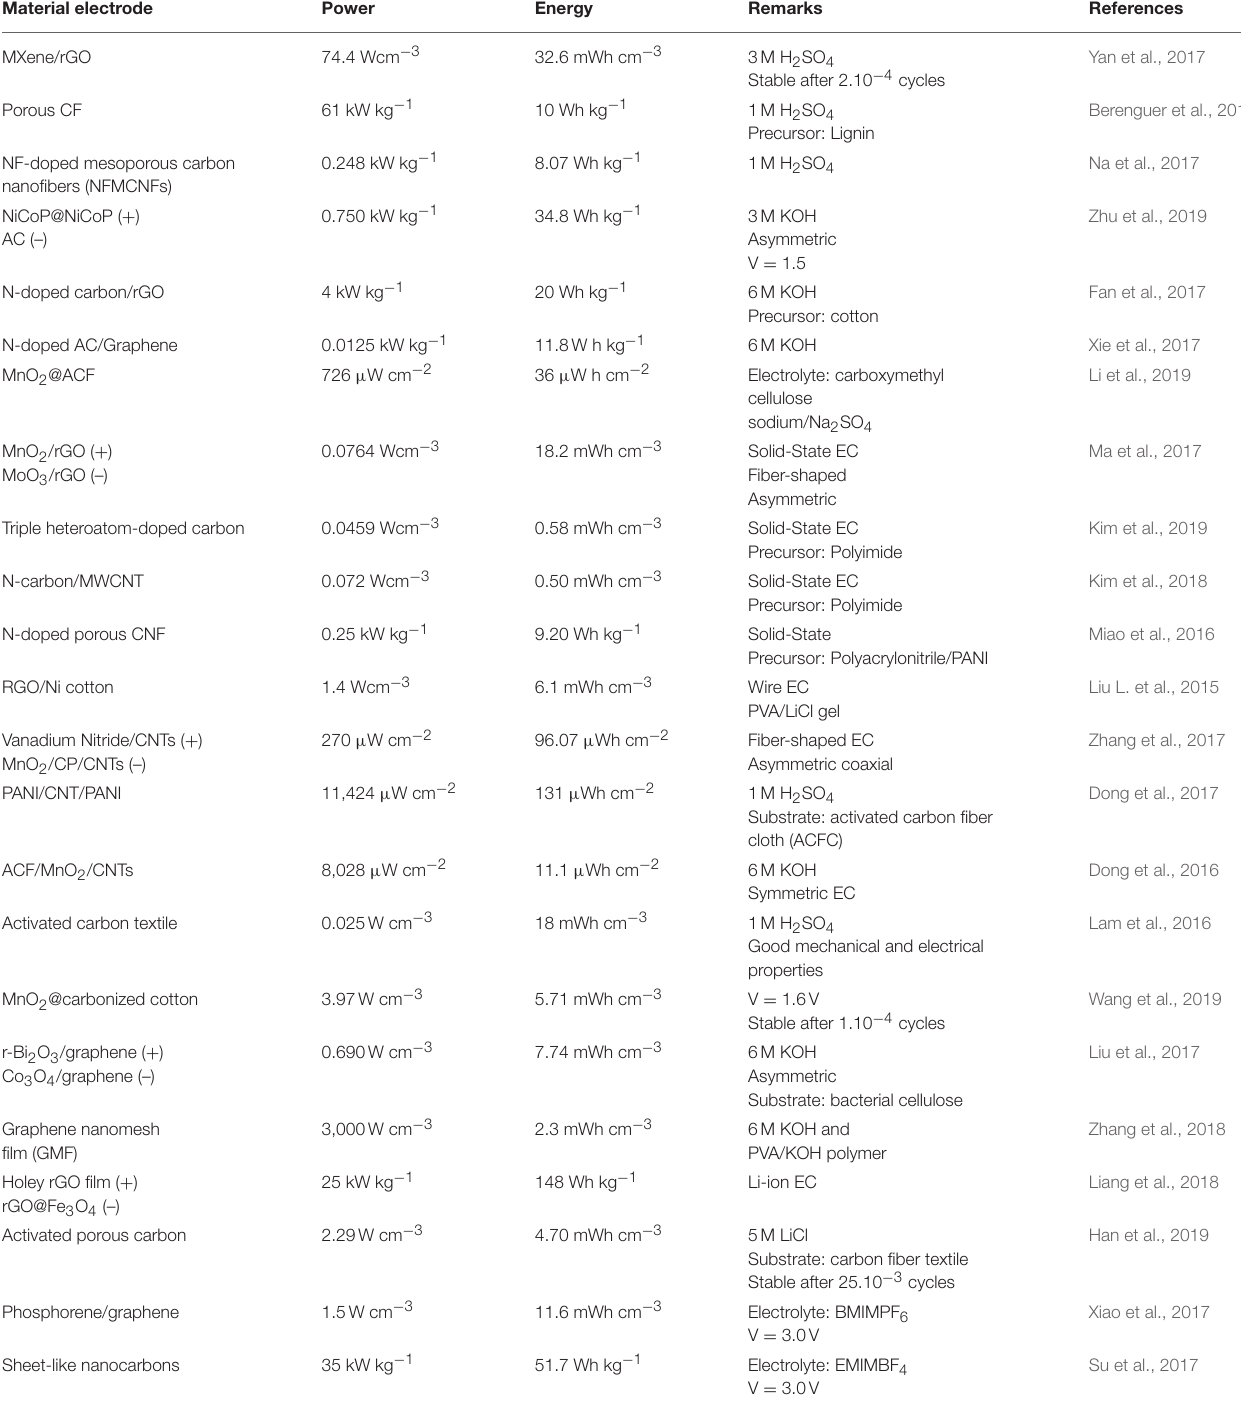
TABLE 6 | Summary of NCMs used as electrodes in flexible